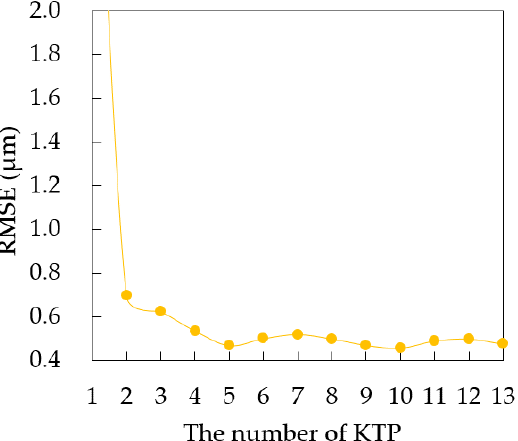
Figure 6. The root mean square errors (RMSEs) for different number of key temperature point